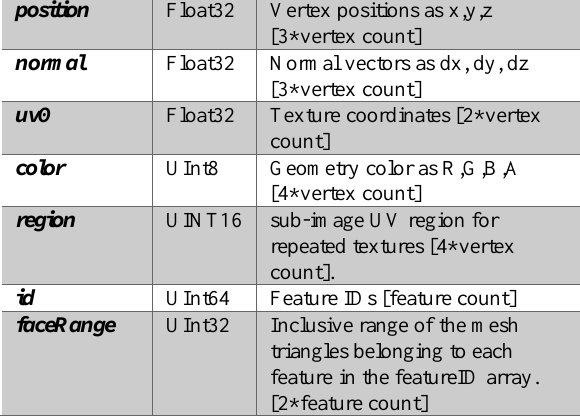
Table 1 . Components of an I3S Geometry buffer.